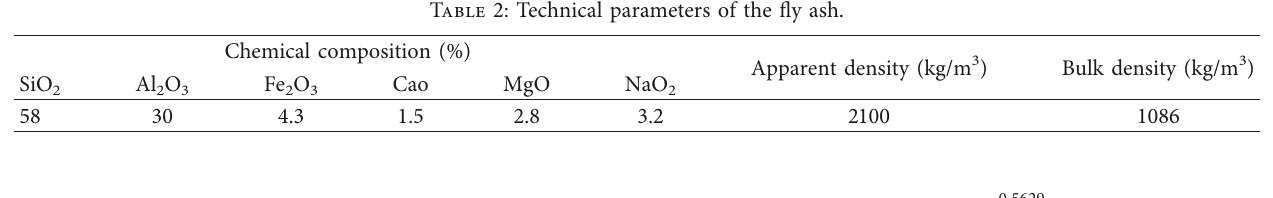
Table 3: Experimental ratio.